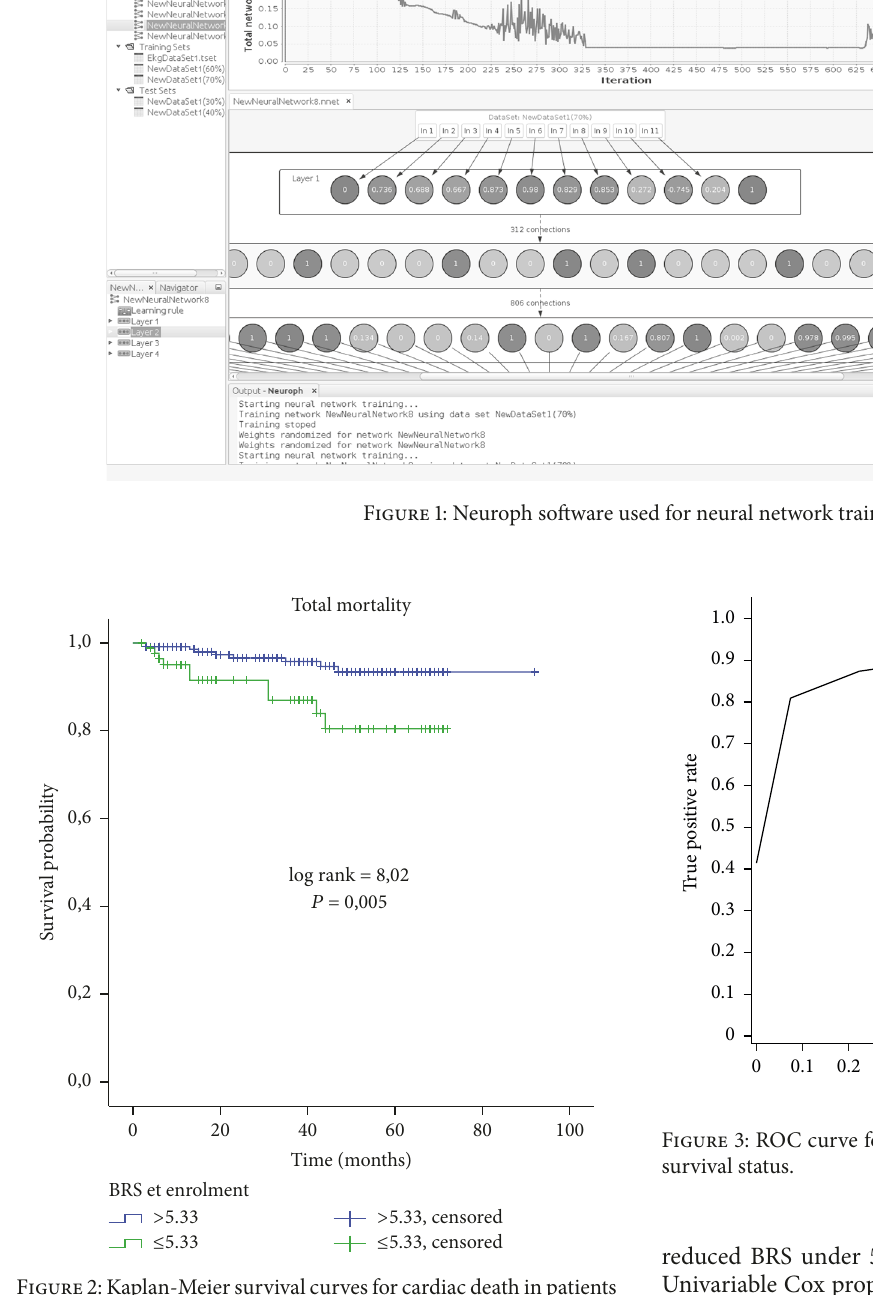
Figure 2: Kaplan-Meier survival curves for cardiac death in patients with reduced BRS at or below 5.33 ms/mmHg in early phase after acute myocardial infarction.